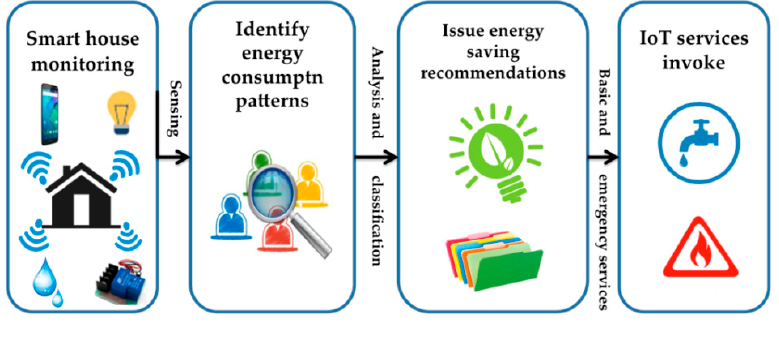
Figure 2. Workflow of HEMS-IoT.